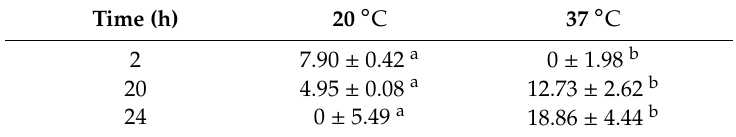
Table 3. Coaggregation (%) ability of Lactococcus lactis subsp. cremoris LL95 to Listeria monocytogenes ATCC 7644 during di ff erent incubation periods and